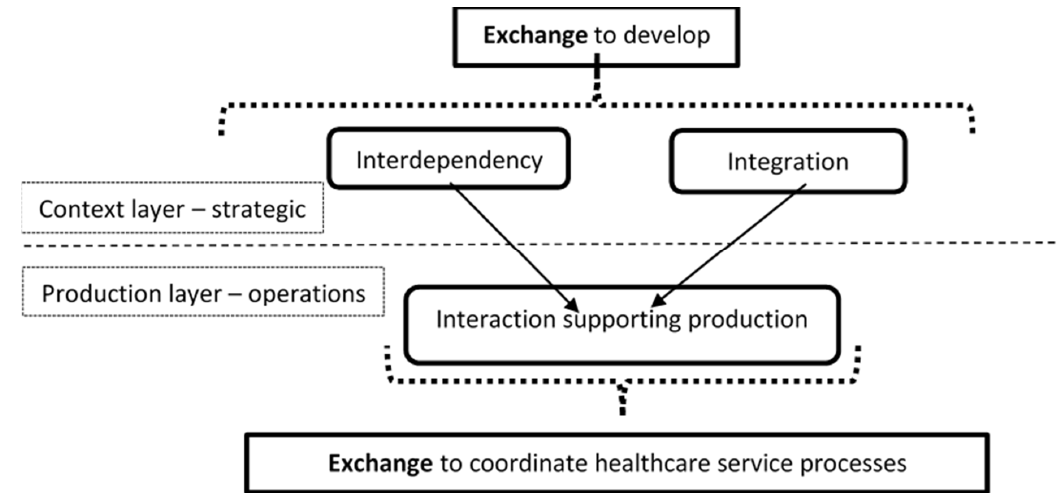
Figure 5. Interdependency, integration, and integration in a service network. Adapted from Engelseth et al. [27].